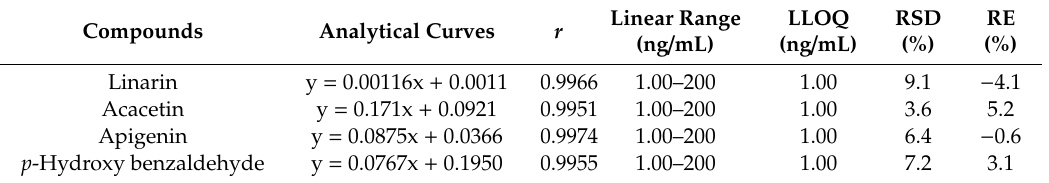
Table 2. Analytical curves, correlation coe ffi cient ( r ), linear range, and lower limit of